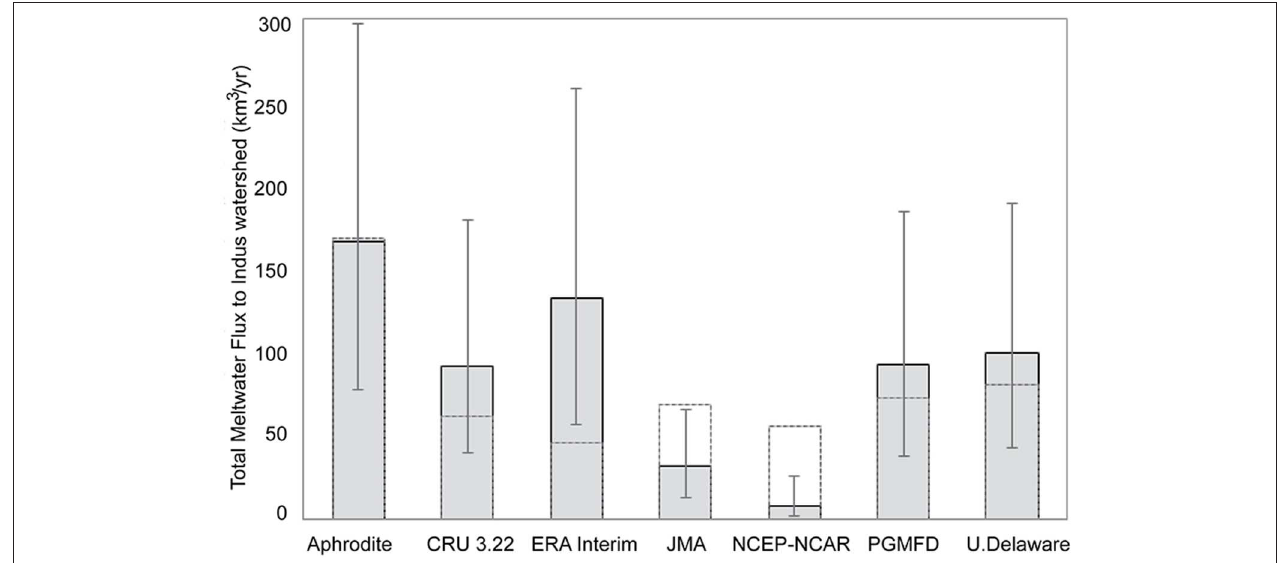
FIGURE 5 | Comparison of watershed-integrated meltwater flux across the Indus watershed for seven climate datasets. The error bars illustrate the extreme minimum and maximum meltwater flux assuming systematic parametrization of the degree-day model. The dashed lines are the integrated meltwater fluxes if temperatures for all datasets are adjusted to the same mean